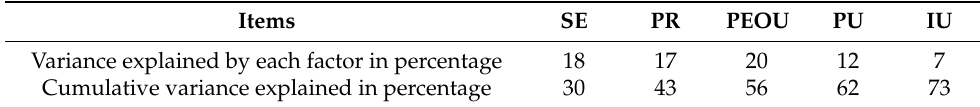
Table 5. Results of variance explained.